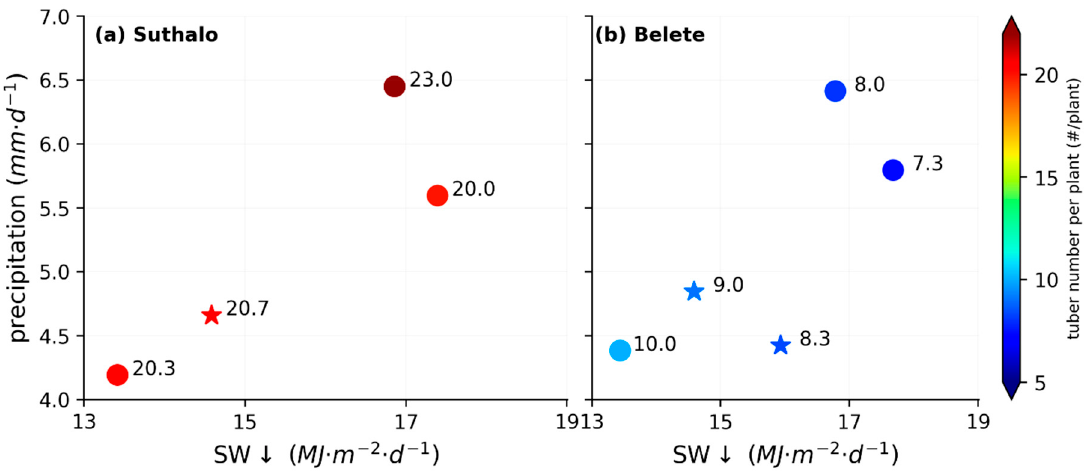
Figure 7. Tuber number per plant (color bar with values shown by the scattered points) at harvest as a function of SW ↓ (MJ · m − 2 · d − 1 ) and precipitation (mm · d − 1 ) for the local ( a ) and improved ( b ) cultivars during belg -2017 (circles) and belg -2018 (stars). The SW ↓ and PPT are mean values in P1.